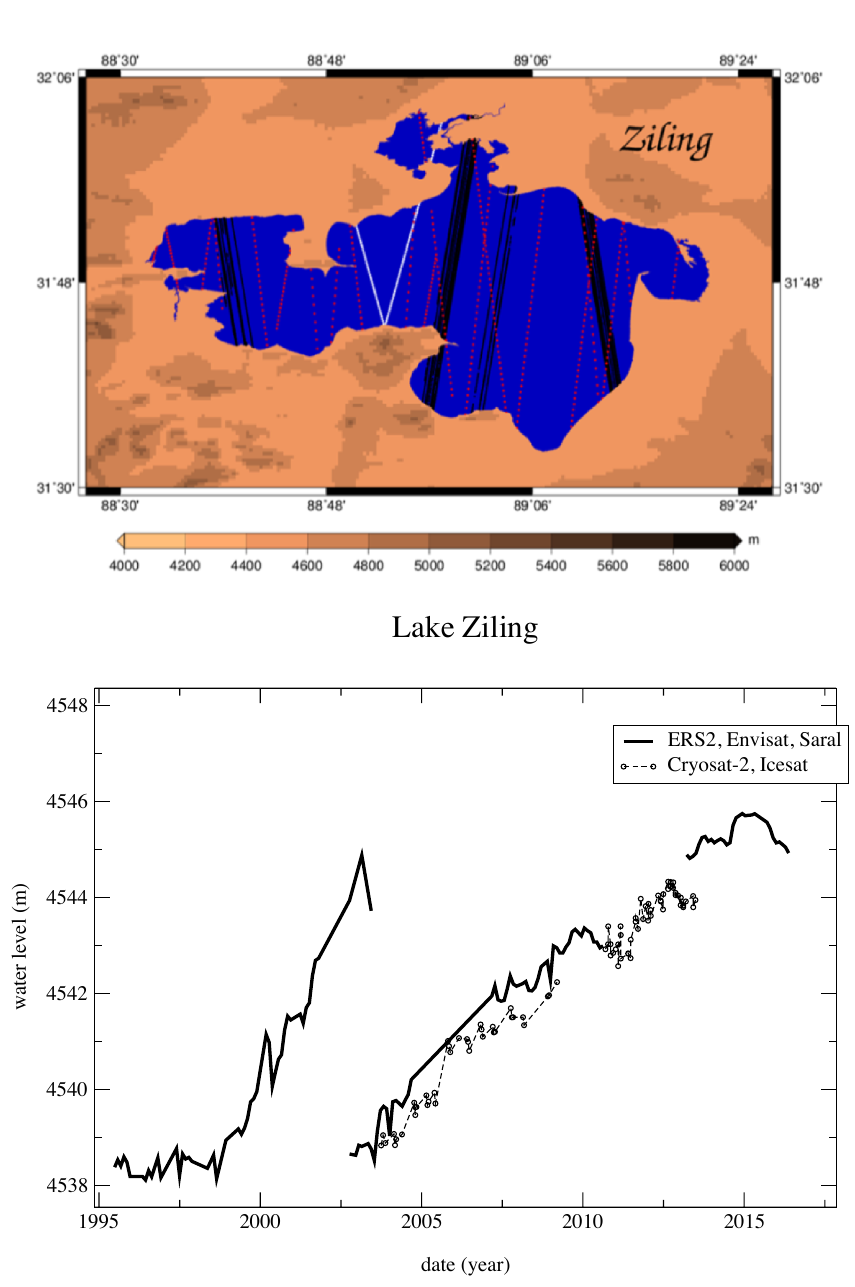
Figure 18. Tracks of satellite altimeters (black: ICESat; red: CryoSat-2; and white: ERS-2, Envisat and SARAL/AltiKa ) over the Ziling Lake, one of the largest of the Tibetan Plateau ( top ); and water level changes from each satellite before correcting from inter-satellite tracks from 1995 to 2016 ( bottom